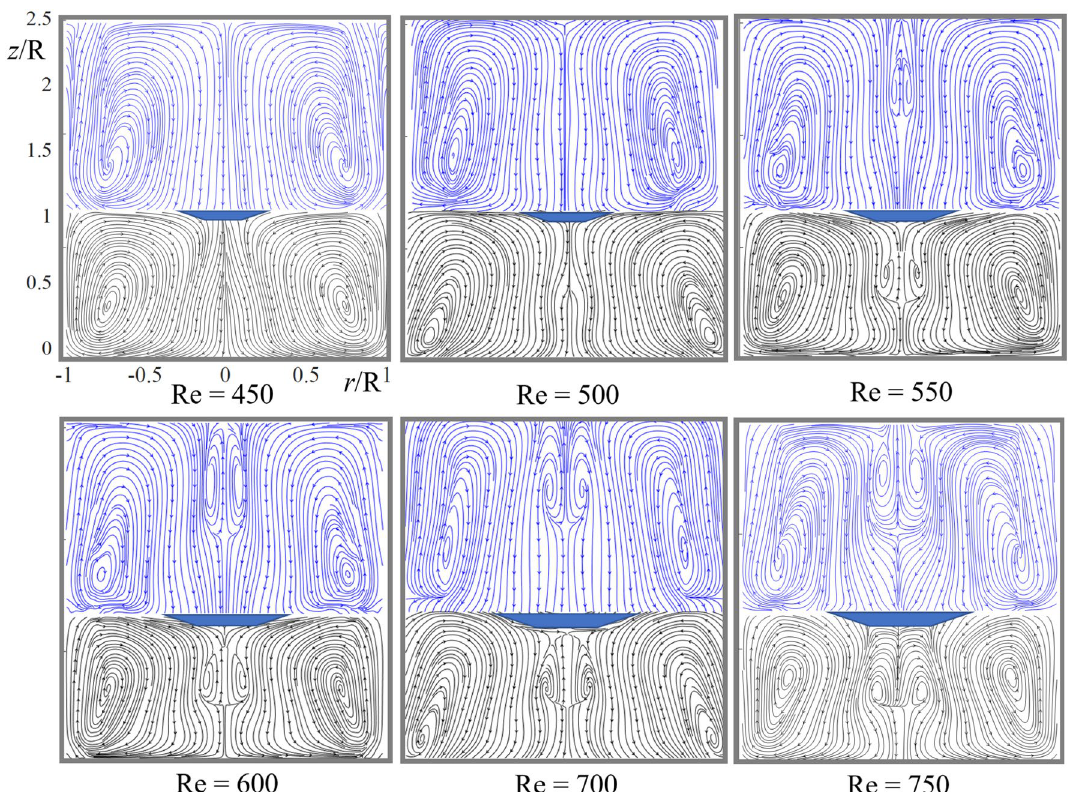
Figure 4. PIV streamline patterns show the development of dual vortex breakdown (VB) in the open container. As the Reynolds number (Re) increases, VB emerges first in the upper fluid and then in the fluid contacting the rotating bottom. (See Supplementary materials for track visualization of double bubble vortex breakdown at high Re.)